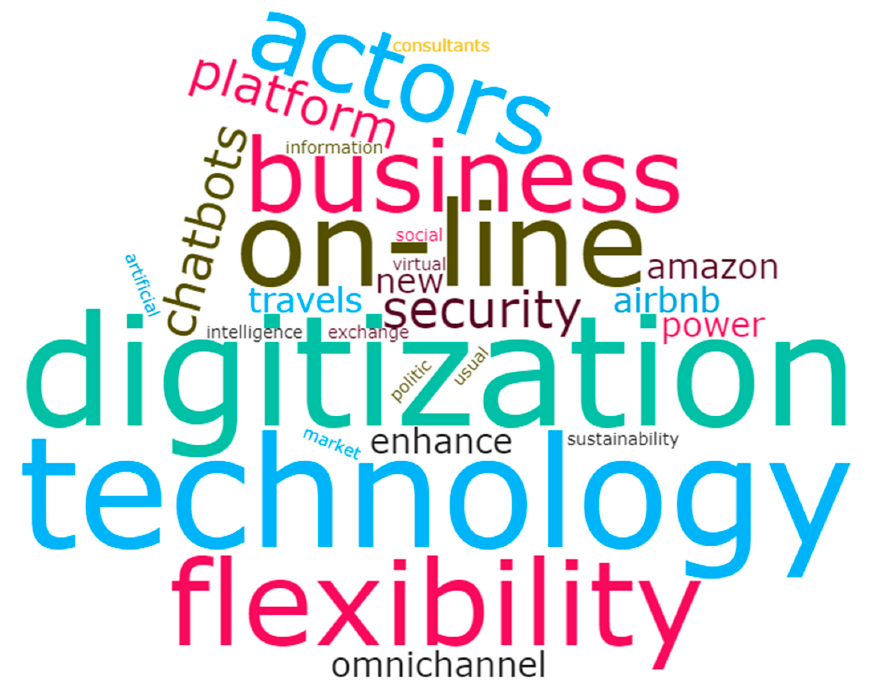
Figure 5. Expected changes in tourism marketing processes. Keywords.